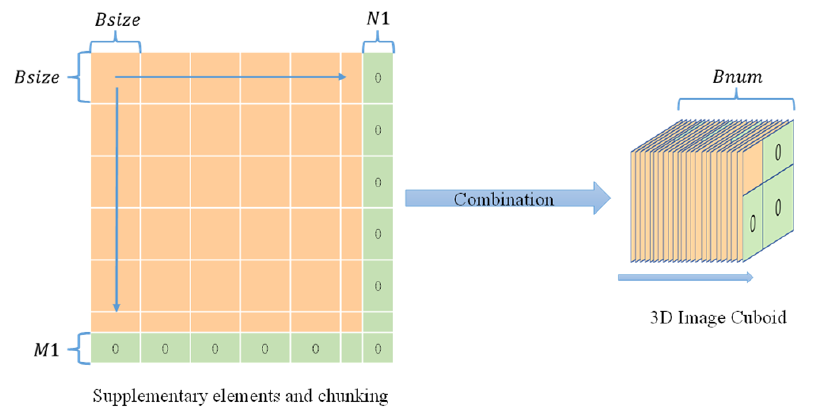
Figure 4. Generation of image cuboid.